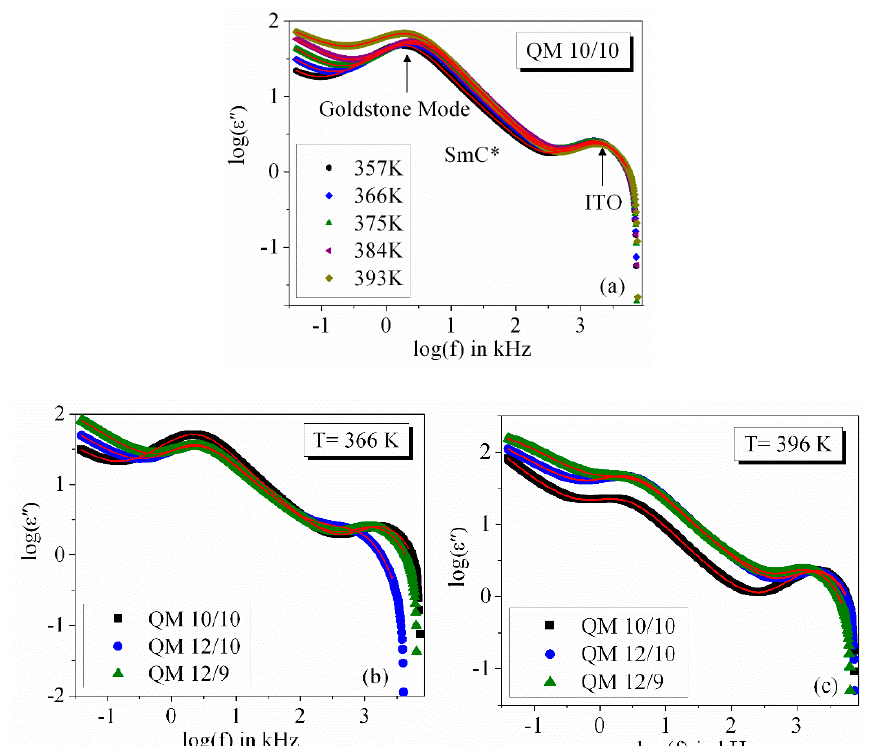
Figure 3. The imaginary part of complex permittivity ( ε ” ) for: ( a ) QM10 / 10 compound at five temperatures as indicated; ( b ) compounds from QMn / m series close to the Cr–SmC* phase transition at T = 366 K; ( c ) compounds from QMn / m series close to the SmC*–N* phase transition at T = 396 K; The red solid curves represent the results of fitting by Havriliak–Negami equation to the experimental data.